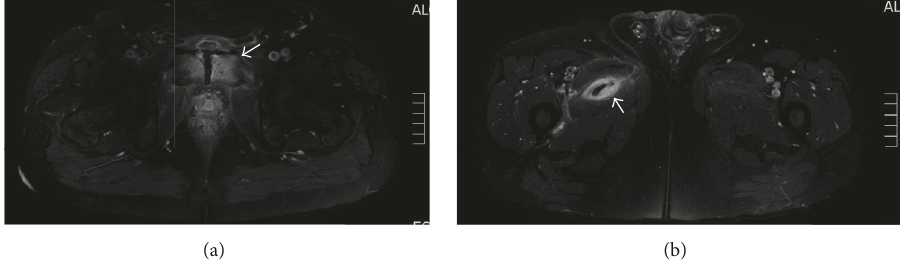
Figure 1: MRI axial imaging of the pelvis and thighs using the SPIR (Spectral Presaturation with Inversion Recovery) hybrid fat suppression technique. (a) Increased bone marrow signal with enhancement involving the symphysis pubis (arrow) consistent with osteomyelitis and moderate surrounding soft tissue edema. (b) A multiloculated fluid collection (arrow), with rim enhancement, within the right adductor muscle, measuring 3.8 ∗ 2.0 ∗ 7 .7 cm.